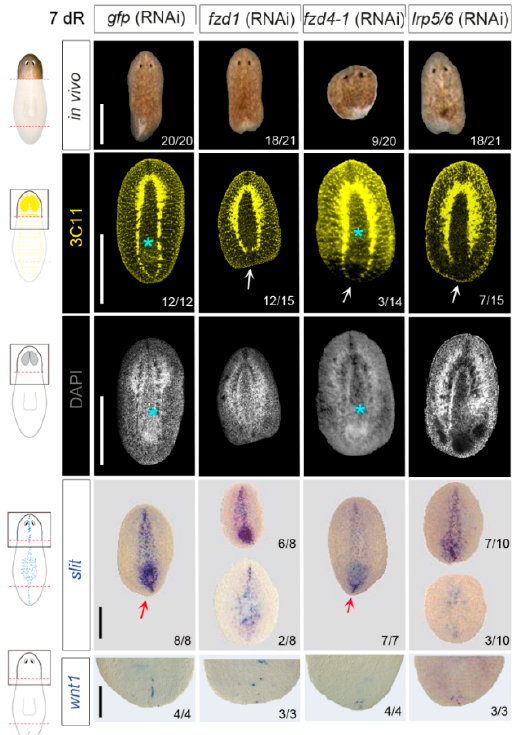
Figure 2. fzd1, fzd4- 1, and lrp5/ 6 inhibition produces tailless heads. In vivo images of fzd1 , fzd4-1, and lrp5/6 (RNAi) regenerating heads showed indented or rounded blastemas. Immunostaining of the neural system using α -SYNAPSIN (3C11) showed that fzd1 , fzd4-1, and lrp5/6 (RNAi) animals do not properly close the ventral nerve chords in the posterior tip (white arrows) and that the new pharynx is not regenerated after fzd1 and lrp5/6 RNAi (cyan asterisks), which is corroborated with nuclear staining (DAPI). WISH using a slit probe shows the disorganization of the midline (red arrows) in fzd1 and lrp5/6 (RNAi) animals. WISH of wnt1 in regenerating blastemas shows its delocalization after the inhibition of the three receptors. On the left, schematic illustrations are added showing which parts were studied (dark boxes) after amputation (red dashed line) and the expression of 3C11, slit, and wnt1 in intact animals. Scale bars: 200 µ